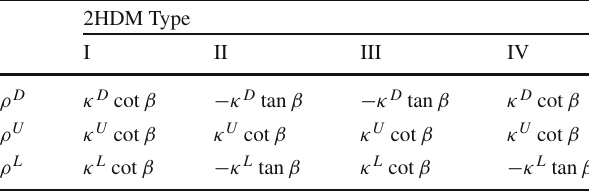
Table 1 Different types of 2HDM in terms of the Higgs boson cou- plings with U (up-type quarks), D (down-type quarks) and L